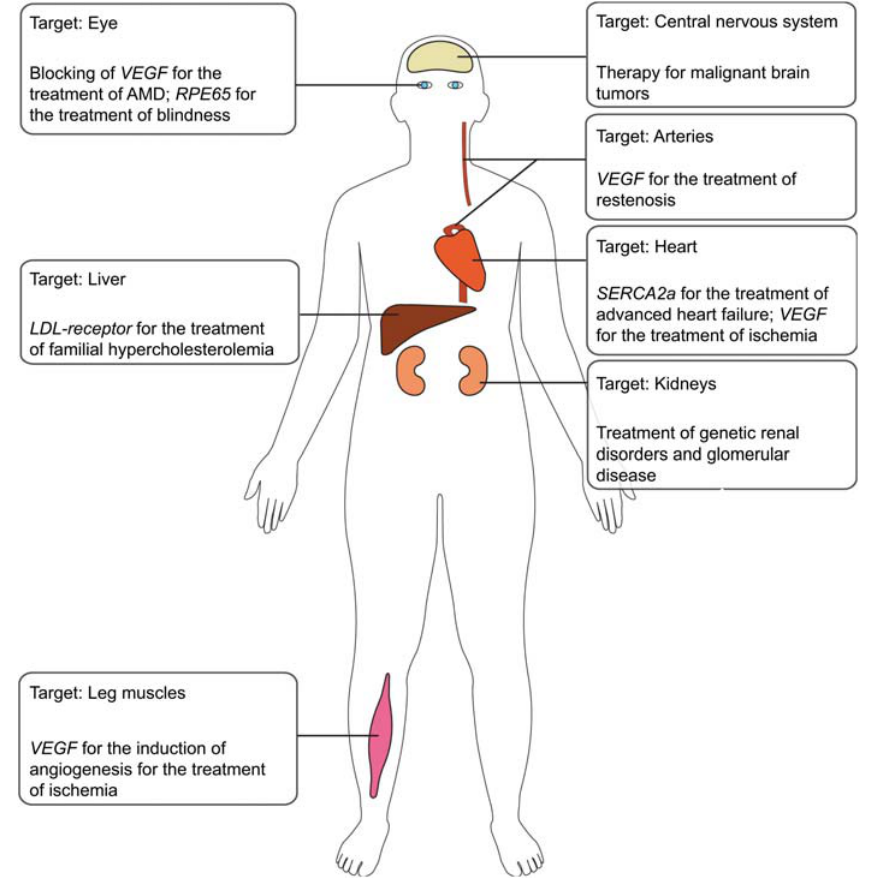
Figure 1 Examples of different gene therapy treatments for various target